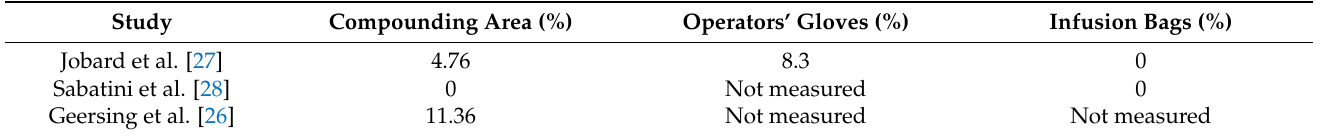
Table 2. Microbial contamination presented as colony detection